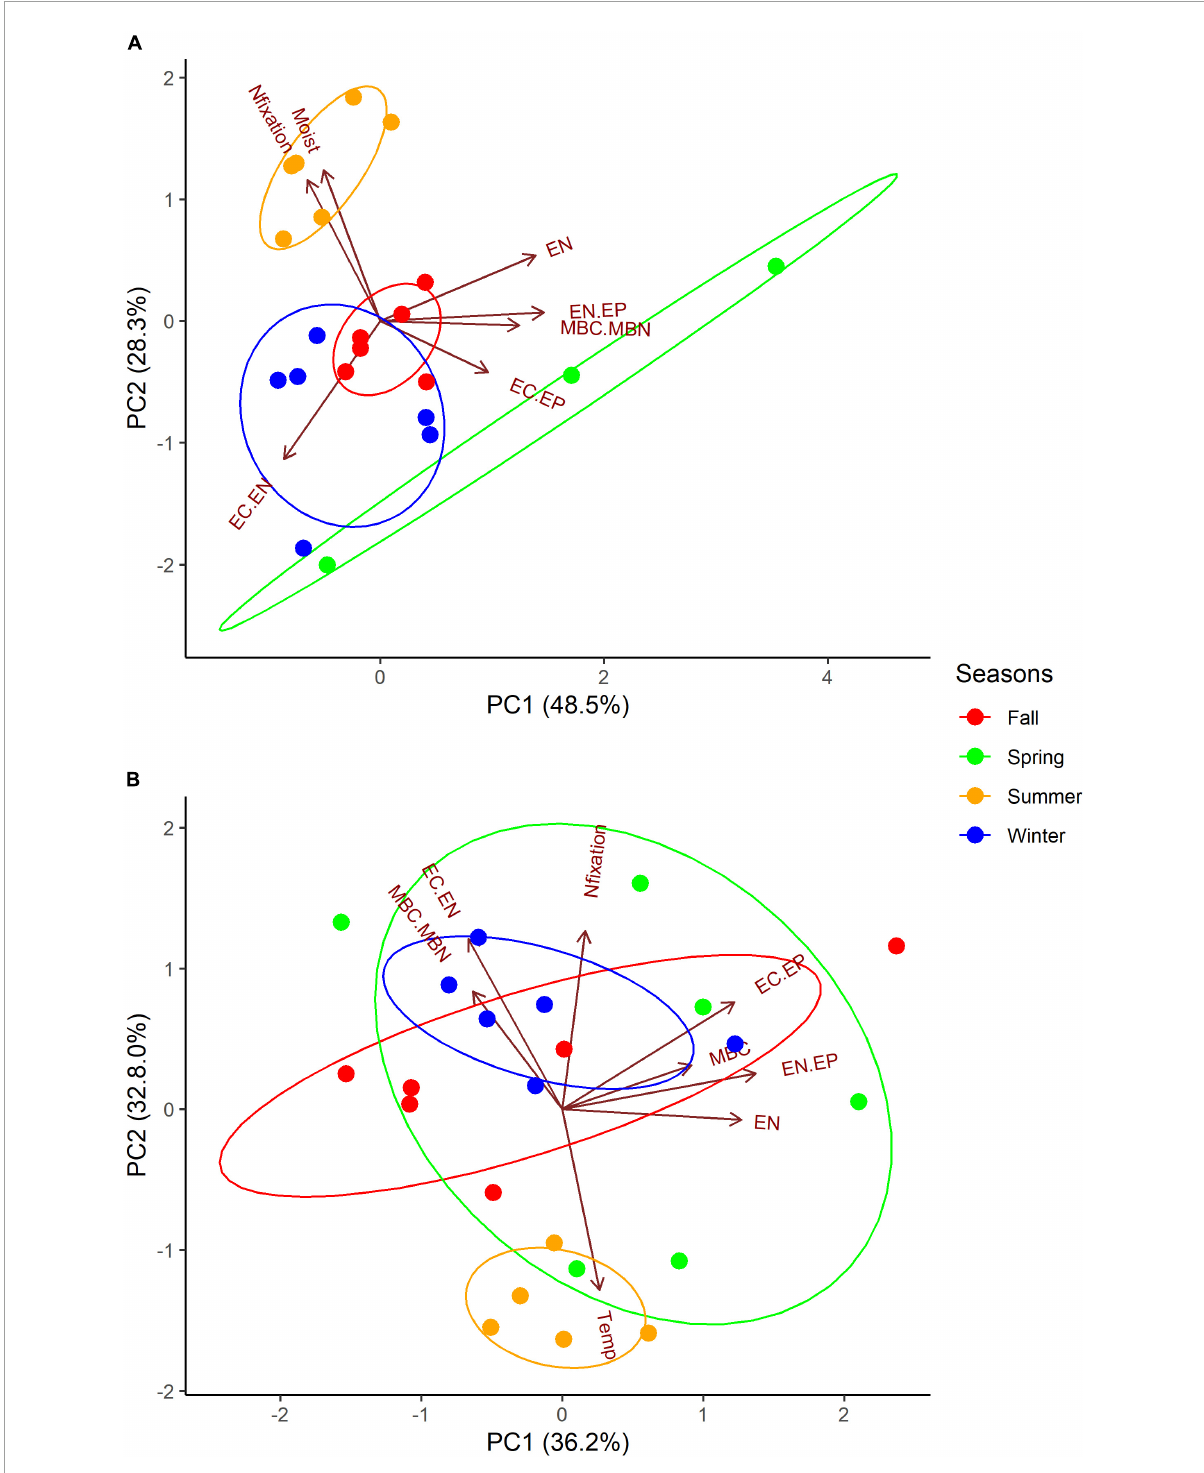
FIGURE3 Principle component analysis (PCA) of seasonally N 2 -fixing biocrusts from (A) Grape ( n = 21) and (B) Citrus ( n = 23). Vectors represent variables with significant loadings used to generate Euclidean distance: N 2 -fixation (Nfixation), biocrust moisture (Moist), soil temperature (Temp), extractable nutrients (EC, EN, EP, EC.EN) and their ratios (EN.EP, EC.EP), and microbial nutrients (MBC, MBN) and their ratio (MBC.MBN). In Grape, the following vectors represent multiple variables: Nfixation (EP) and EN (EC). In Citrus, the following vector represents two variables: EN (EC). Ellipses are drawn around seasons at 98% probability. Vector loadings and their significance with all variables included are shown in Supplementary Table 3 . PerMANOVA results of differences based on the season are shown in Supplementary Table 4